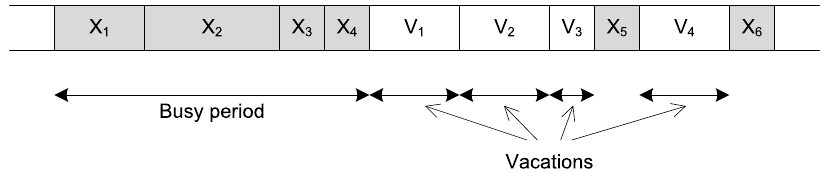
Figure 3. M/G/1 queueing model with vacations. During busy periods, the server is servicing jobs. During vacation periods, the server is “away” and jobs may be waiting in the